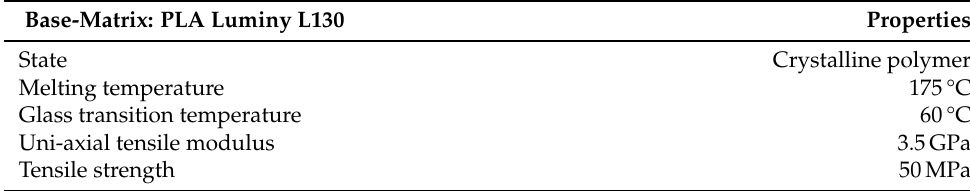
Table 3. Material properties of the type A base-matrix